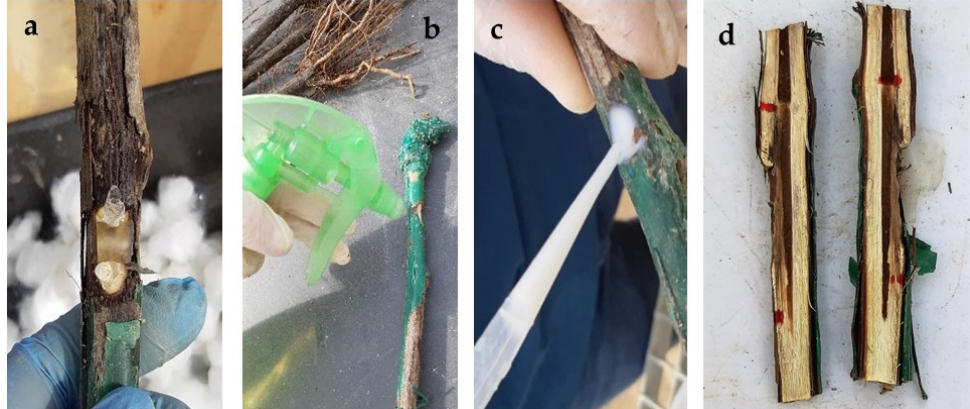
Figure 1. BCA application procedures. ( a ) Treatment with T. harzianum inocula dispersed in alginate beds placed at both sides of the agar plug together with the pathogen; ( b ) spraying of T. atroviride inocula; ( c ) application of Bacillus spp.-based treatments using a pipette; ( d ) longitudinally opened plant showing vascular necroses from the inoculation points.